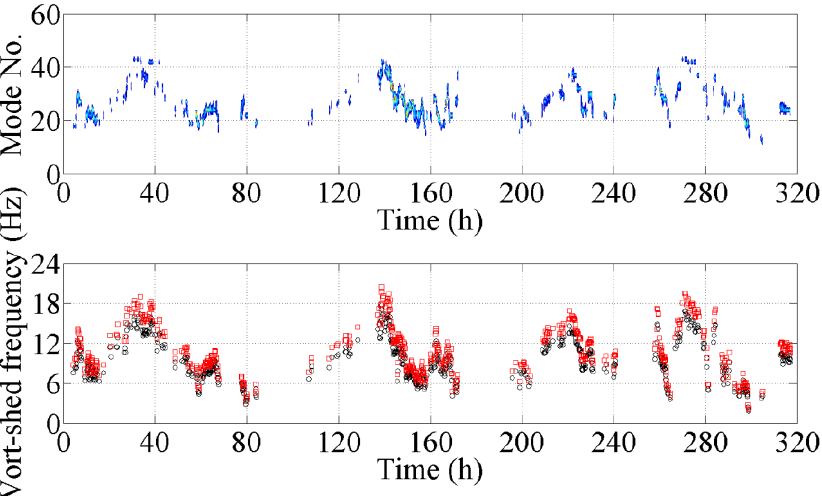
Figure 17. Change of measured vibration modes and estimated vortex-shedding-frequency range with time.